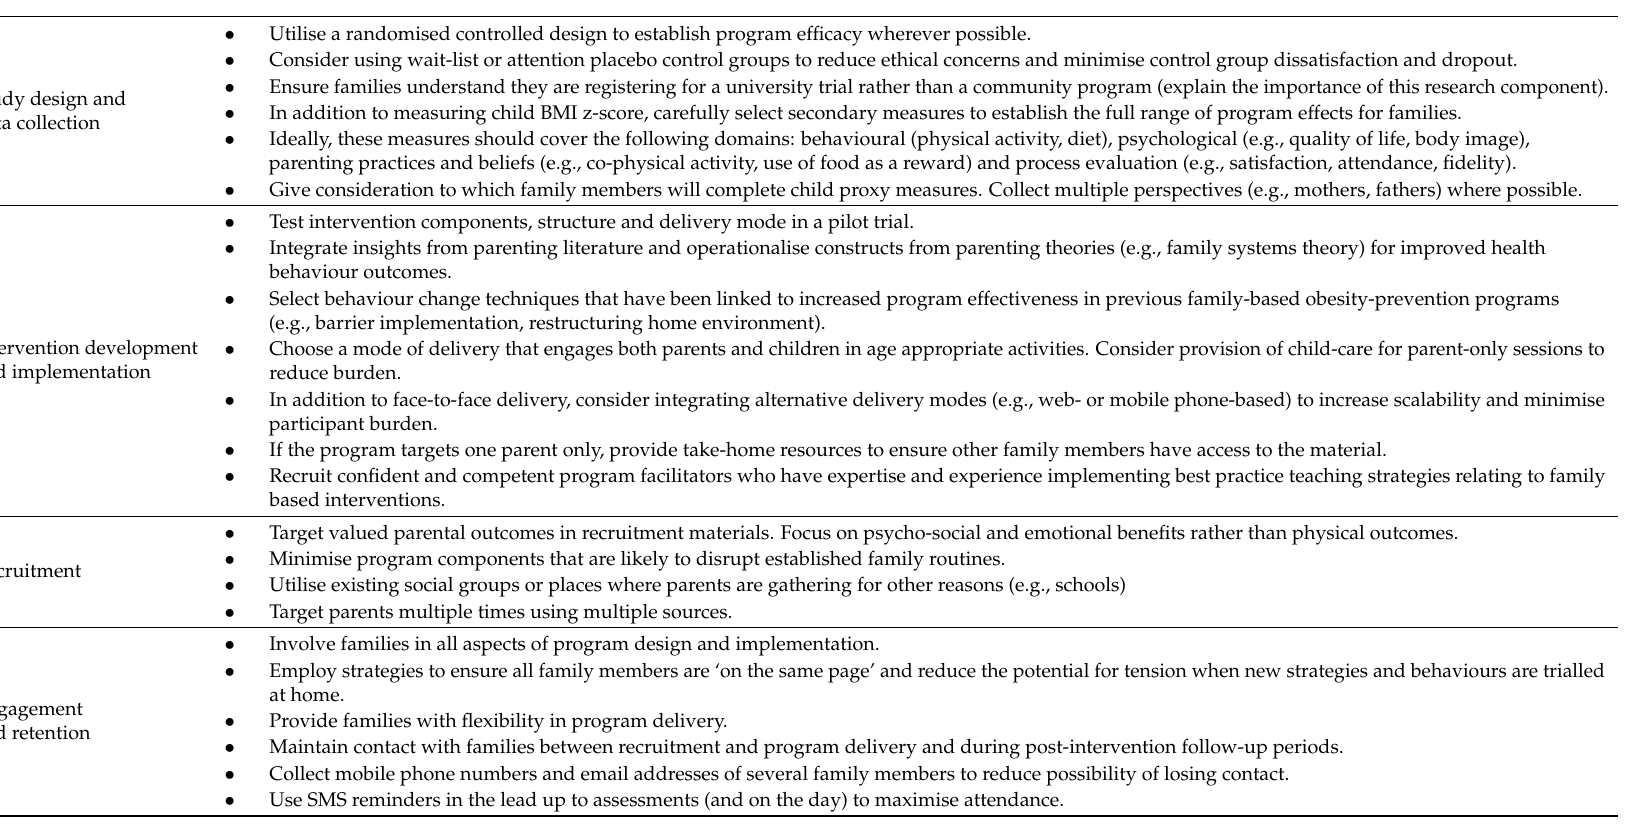
Table 2. Recommendations and considerations for conducting childhood obesity prevention research studies with